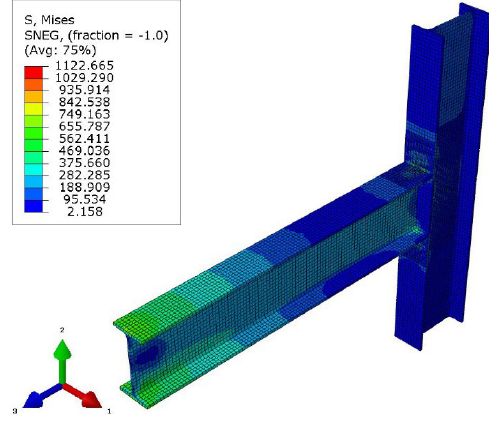
Figure 13. Strengthening scheme for the connection . The CFRP laminates are modelled with shell elements, type S4, of size 10 mm. The results of the simulations in terms of the von Mises stress, corresponding to a vertical displacement of the beam of approximately u = 20 mm, are shown on Figure 14.